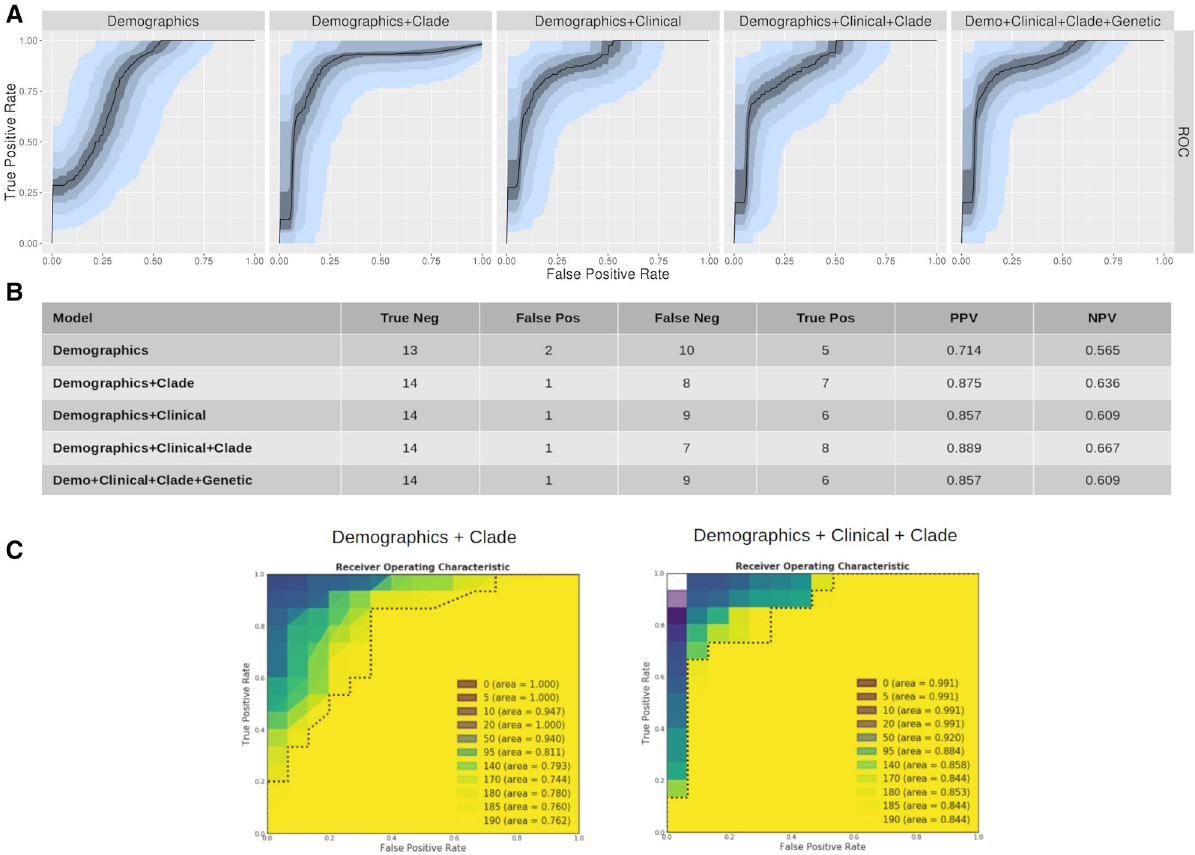
Figure 4. Machine learning models for prediction of hospitalization using hold-out set of 15 most-recent hospitalizations and 15 most-recent non-hospitalizations. ( A ) AUROC for machine learning models on hold-out set. ( B ) Optimal model performance for each dataset model for prediction of hospitalization. ( C ) Model AUROC for spiked dataset ranging from 100% strain concordance with hospitalization (0) to complete randomization of outcome with respect to clade (190). Note that models approach observed AUROC with 50/160 randomized with respect to